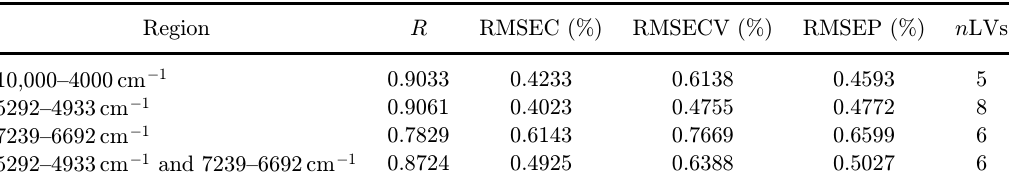
Table 3. Model results with di®erent regions by manual selection.